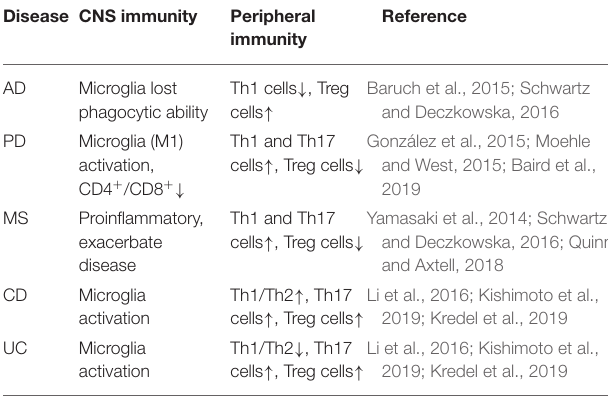
TABLE 2 | Changes of immune cells in neurodegenerative diseases/IBD. Disease CNS